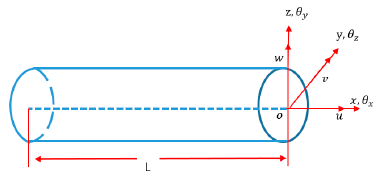
Figure 1. Beam kinematic variable fields.